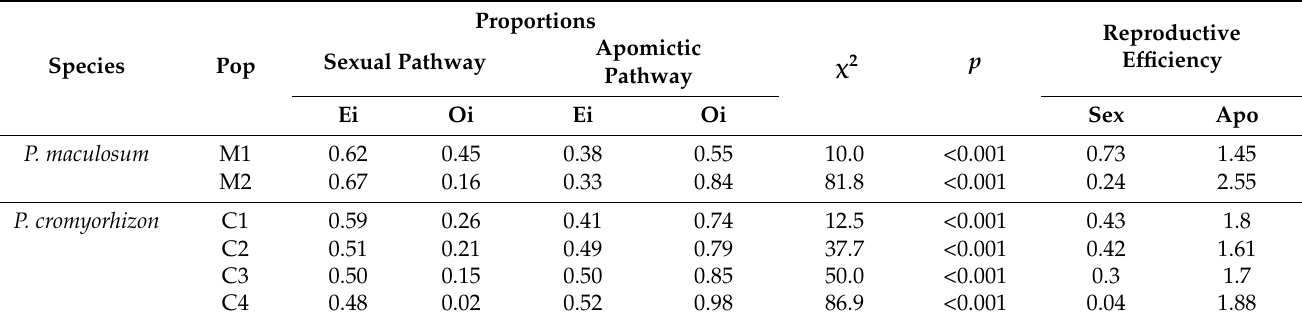
Table 4. Expected (Ei) and observed (Oi) proportions of sexuality and apomixis at the seed stage and the reproductive efficiency of each pathway.